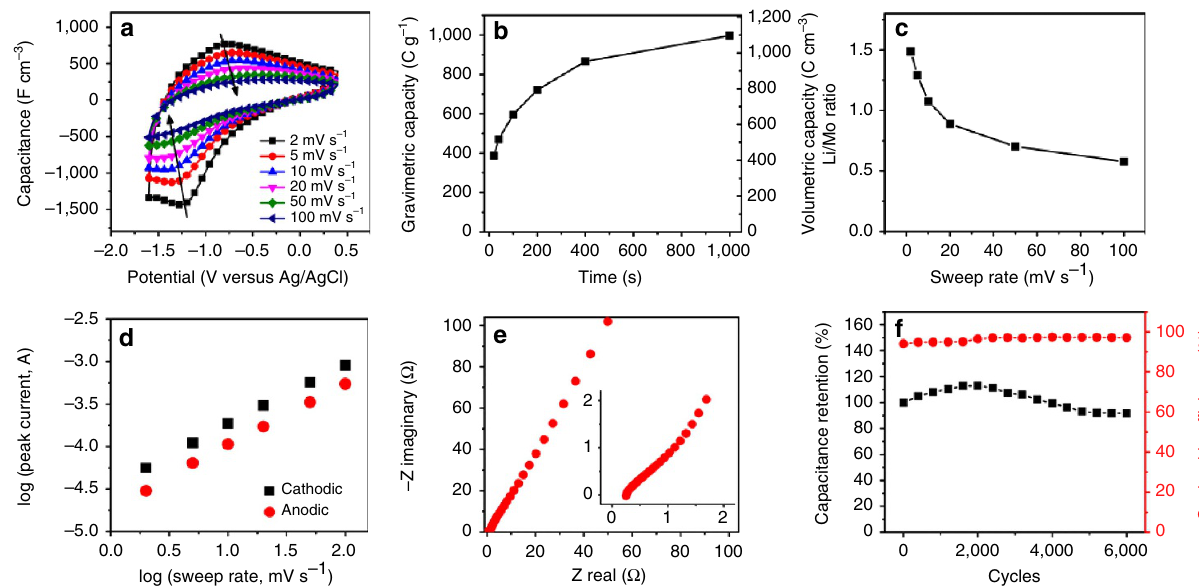
Figure 5 | Electrochemical performance of 2D h -MoO 3 in a Li-ion-containing organic electrolyte. ( a ) CV curves at sweep rates ranging from 2 to 100mVs (cid:2) 1 indicating the small peak shifts following the arrows. ( b ) Gravimetric and volumetric capacity as a function of charging/discharging time. ( c ) Li/Mo ratio at different sweep rates using x ¼ QM / mF , where Q is the stored charge, M is the molecular weight, m is the mass and F is the Faraday constant. After 1,000s, 2D h -MoO 3 reaches 1.49 Li/Mo, approaching the theoretical value for bulk a -MoO 3 (1.5). ( d ) Plot for calculating b values of the cathodic and anodic peaks (both ¼ 0.9). ( e ) Nyquist plots. ( f ) Cycling stability and Coulombic efficiency over 6,000